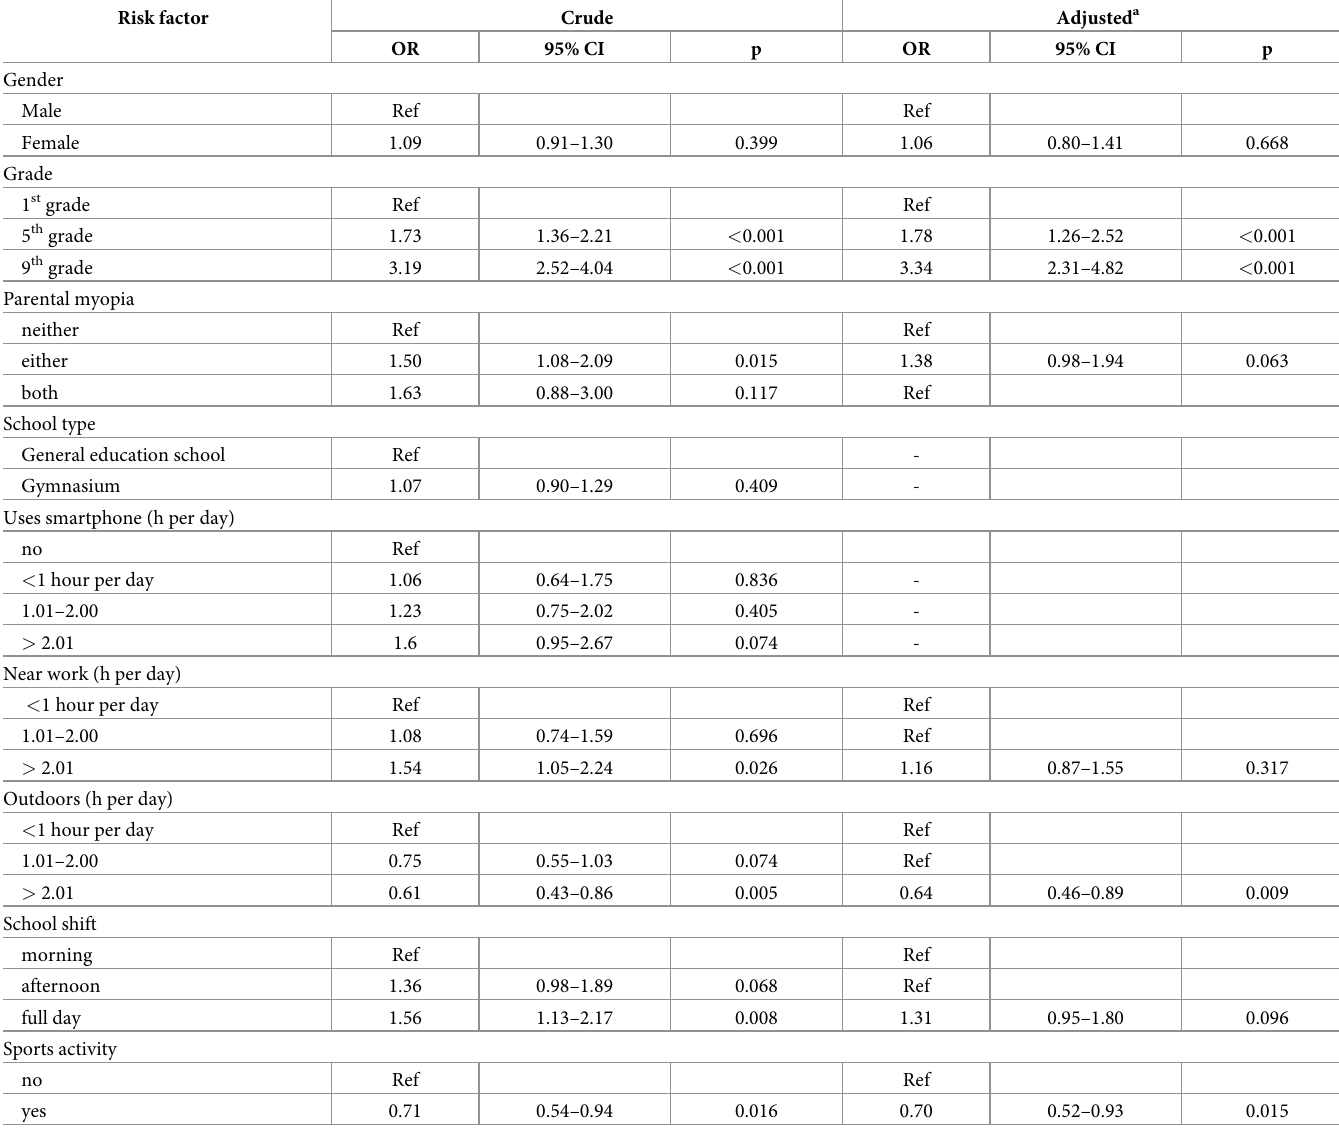
Table 4. Risk factors of myopia from regression